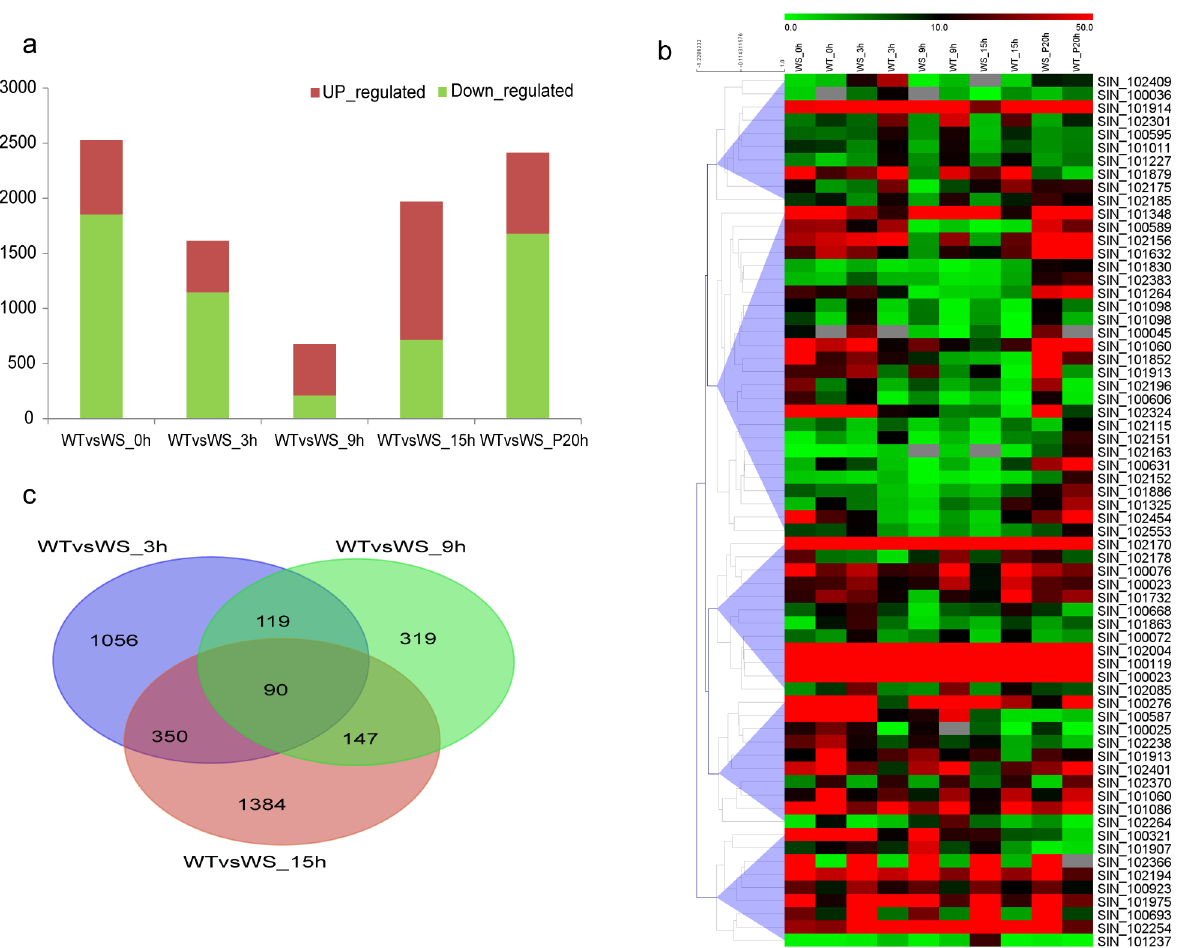
Fig 4. Comparisons between WT and WS plants during waterlogging and post-drainage. (a) DEGs in WT versus WS plants at various waterlogging time points revealed that waterlogging has a severe effect on gene expression at 9 h. (b) Expression patterns of the 66 common DEGs between WT and WS under waterlogging conditions. The RPKM values were log2 transformed. (c) A Venn diagram depicting the common and unique DEGs between 3 and 15 h of waterlogging in WT and WS